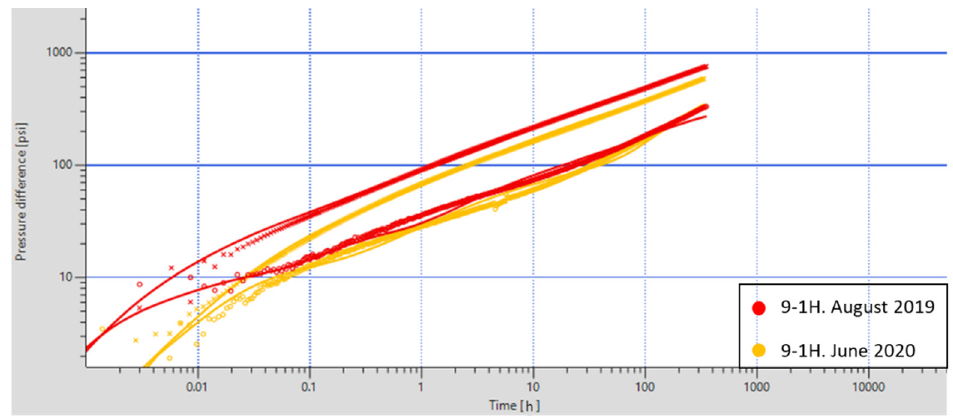
Figure 14. 9-1H well test Figure 14. 9 ‐ 1H well test curve.